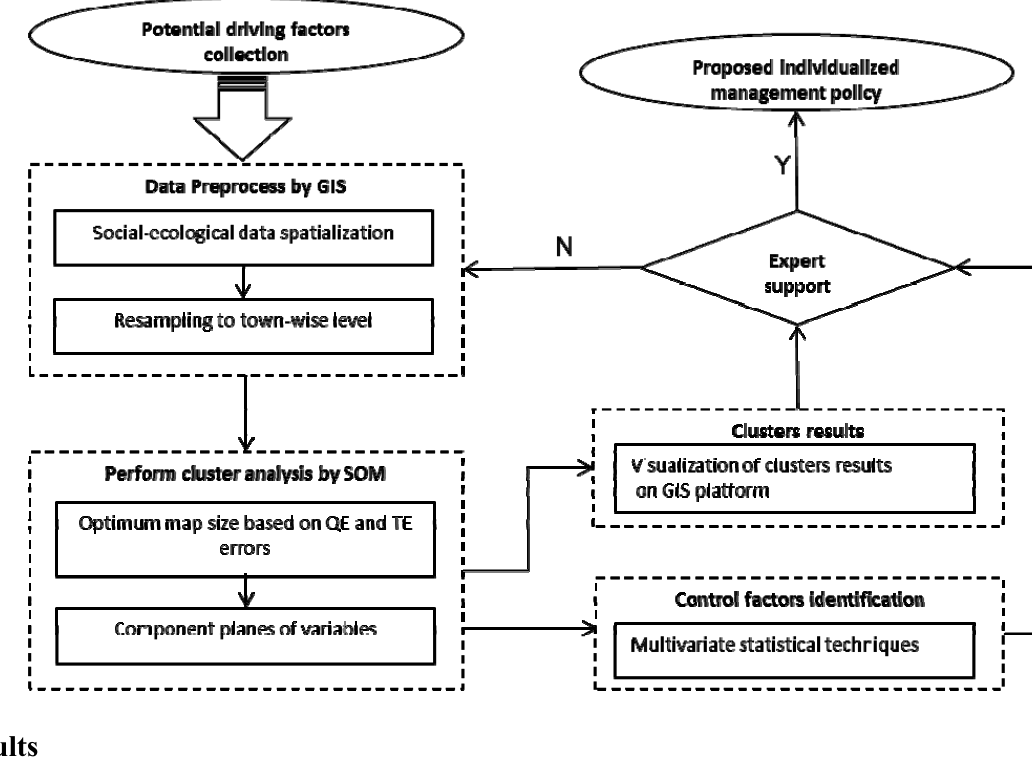
Figure 4. Flow chart of SOM for heavy metals socio-ecological pattern